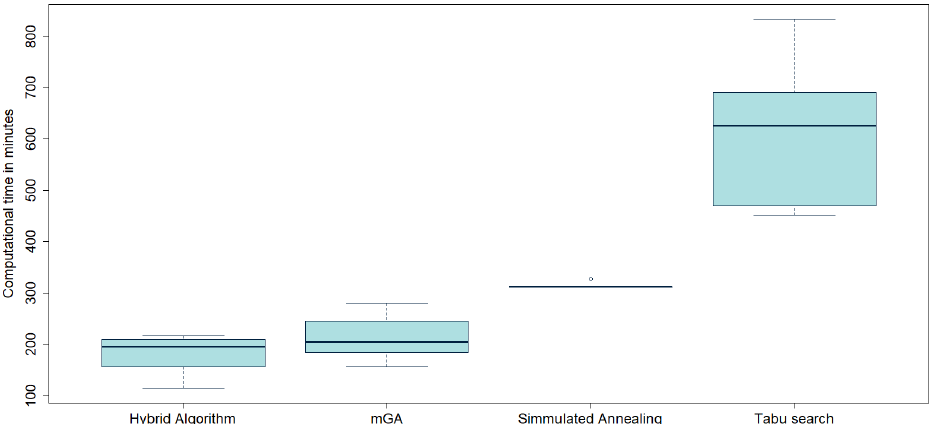
Figure 15. Box plot comparing the computation time for all four algorithms using a randomly generated solution as the initial solution.